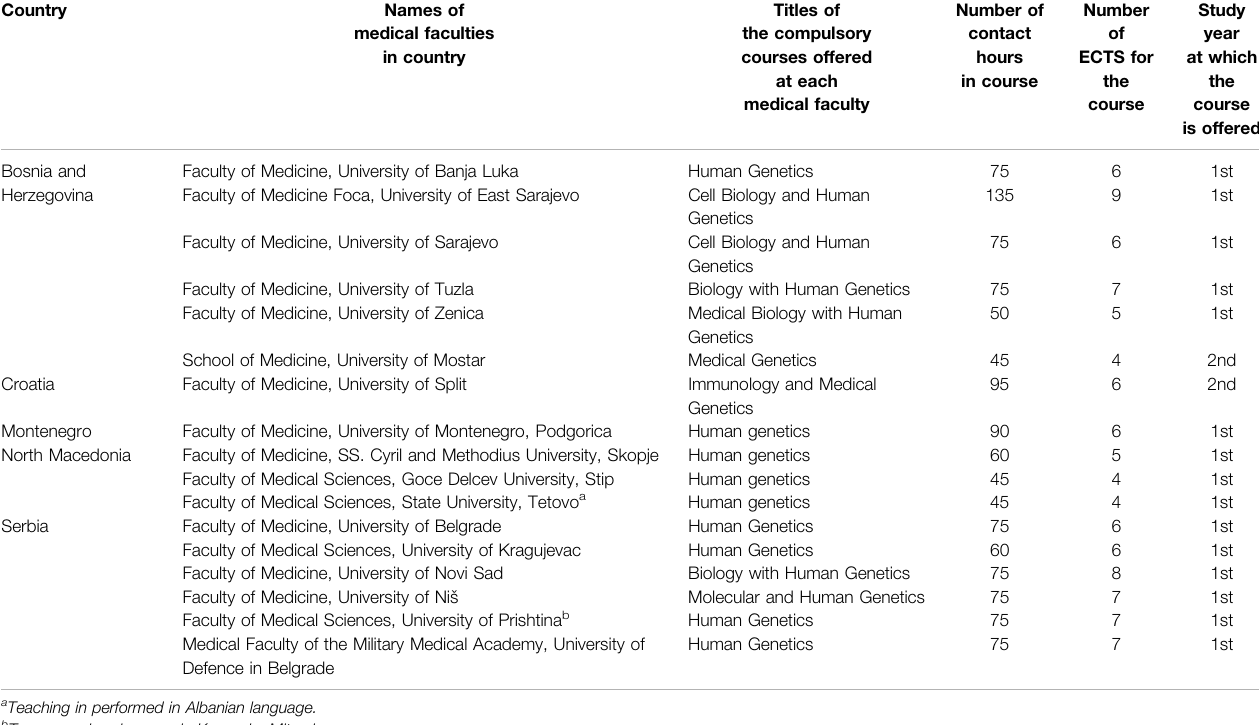
TABLE 1 | Basic courses in genetics offered at medical faculties for medical students in Balkan countries with Slavic languages. Country